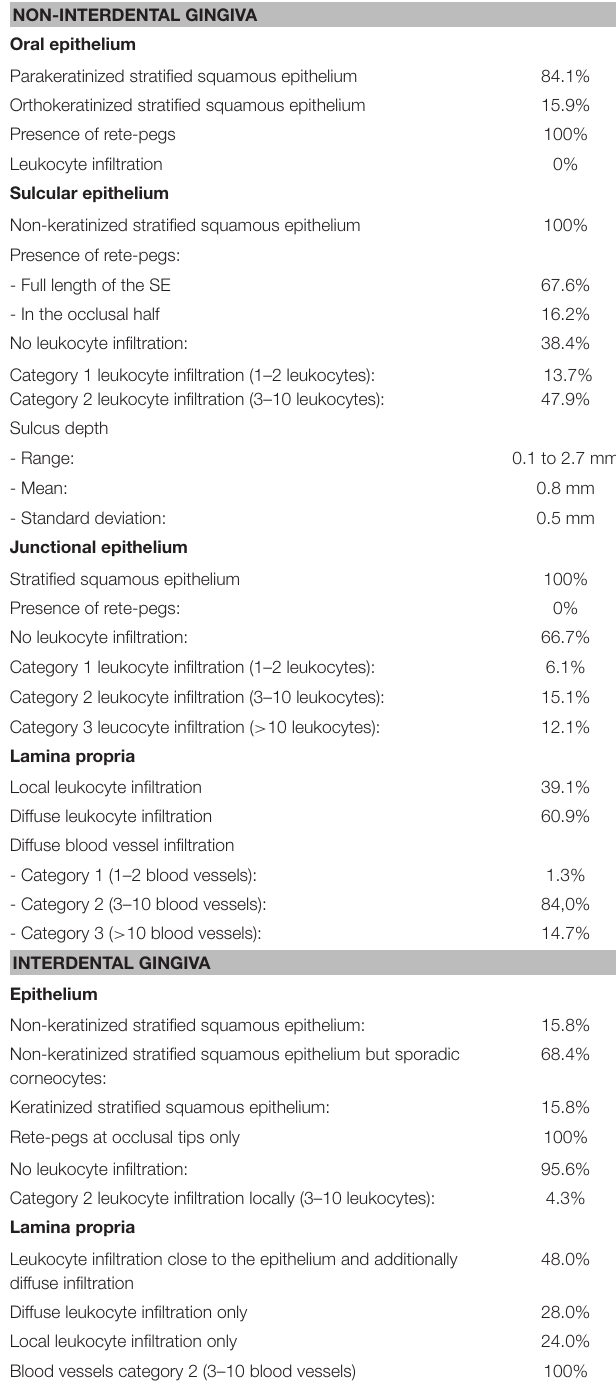
TABLE 3 | Characteristics of the histology of the equine